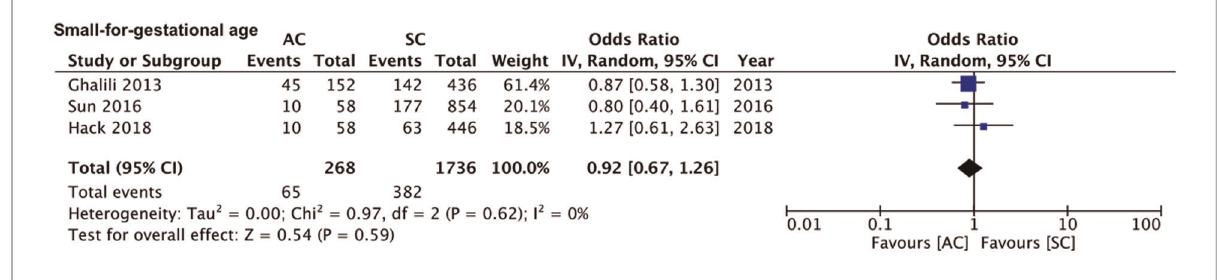
FIGURE 9 Meta-analysis of SGA between assisted and spontaneously conceived monochorionic twin